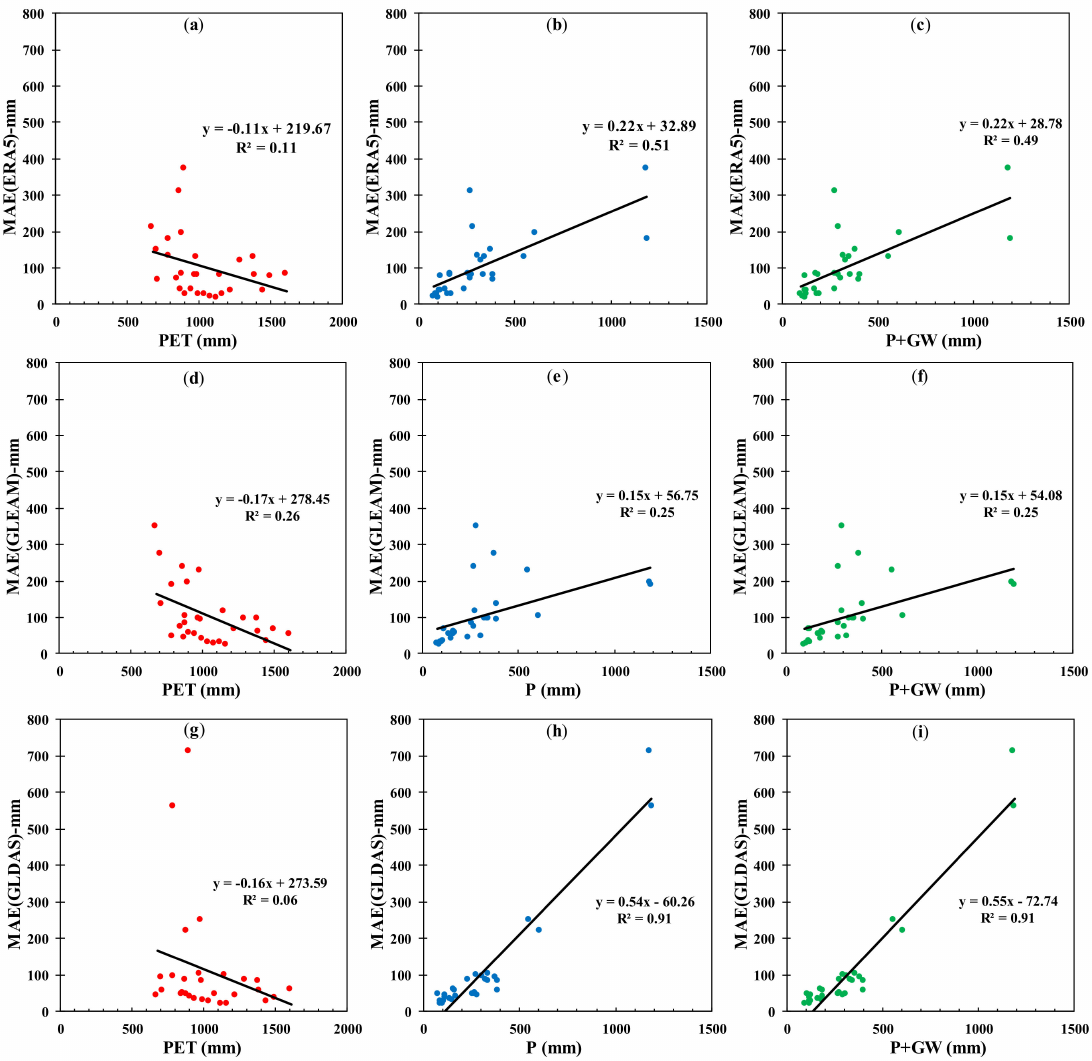
Figure 9. Co-variation of mean absolute error (MAE) of ( a , b , c ) ETERA5, ( d , e , f ) ETGLEAM, and ( g , h , i ) ETGLDAS with ( a , d , g ) potential evapotranspiration (PET), ( b , e , h ) precipitation (P), and ( c , f , i ) P + groundwater